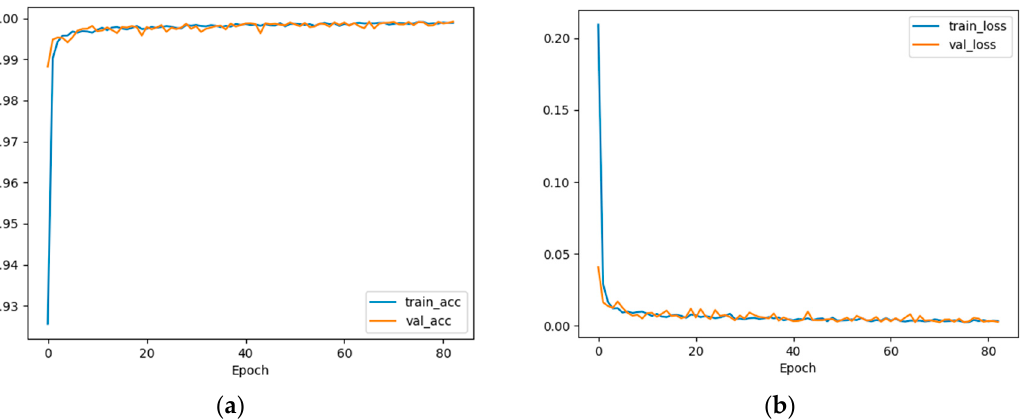
Figure 6. Accuracy and loss value curves of the IEEE14-bus test system. ( a ) Accuracy value curves of the IEEE14-bus test system. ( b ) Loss value curves of the IEEE14-bus test system.